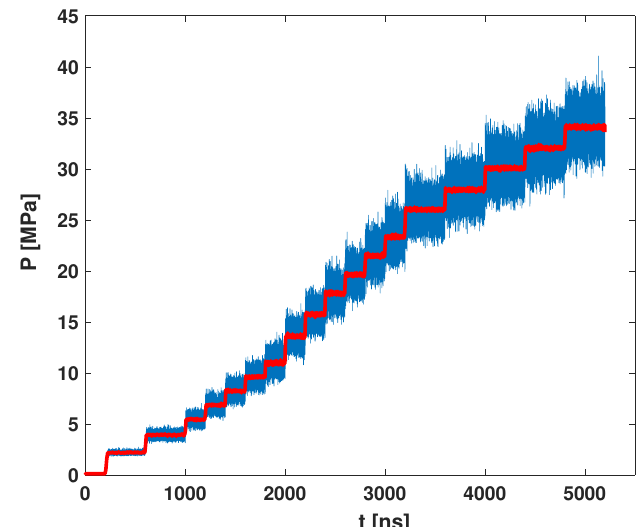
Figure 3. System pressure in the simulation. We increase the pressure step-by-step to reach the startup pressure for nucleation. The blue line is the raw data and the red line is the ensemble average value over